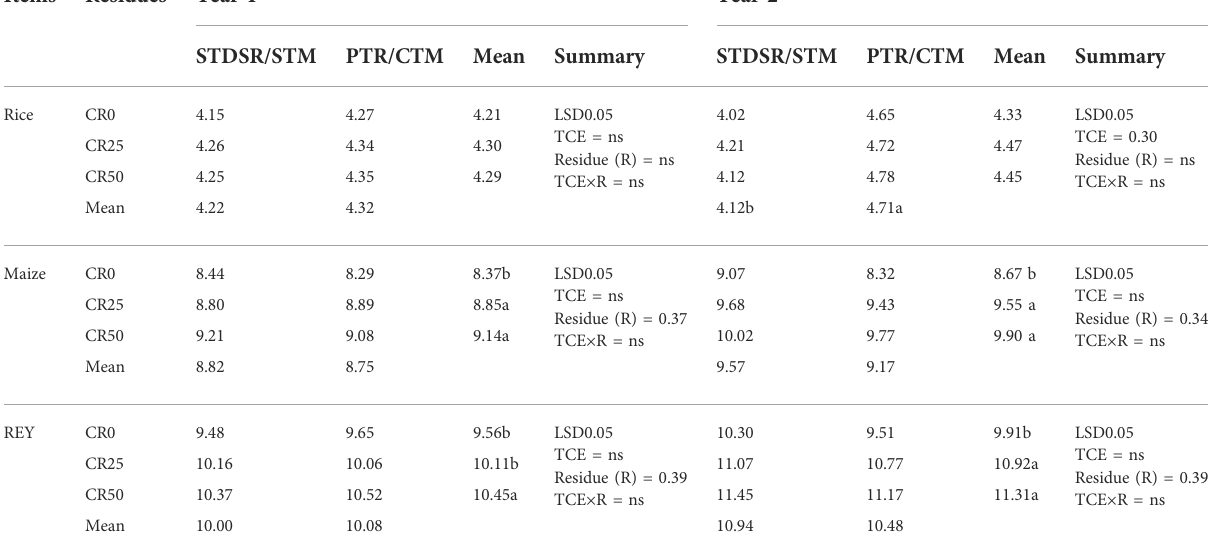
TABLE 5 Rice and maize grain yields and rice equivalent yield (REY) (Mg ha − 1 ) in Rice-Maize cropping systems during 2019 – 2020 and 20 – 21.